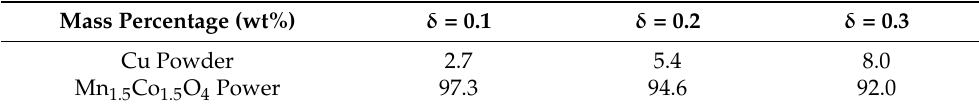
Table 1. The raw material ratio to prepare Cu δ Mn 1.5 − x Co 1.5 − y O 4 powders.